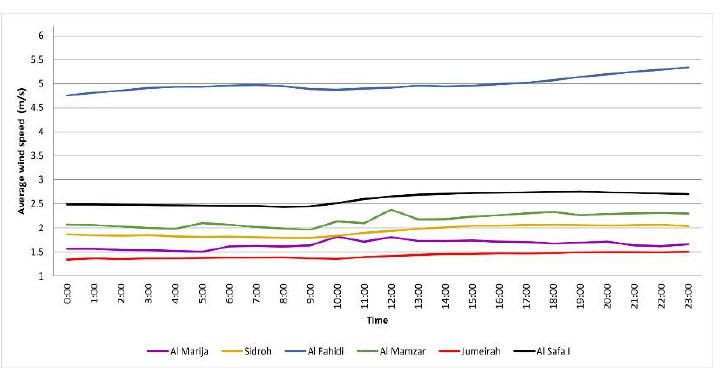
Figure 12. Hourly variations of wind speeds (m/s) for Al Marija, Sidroh, Al Fahidi, Al Mamzar, Jumeirah, and Al Safa I in December.